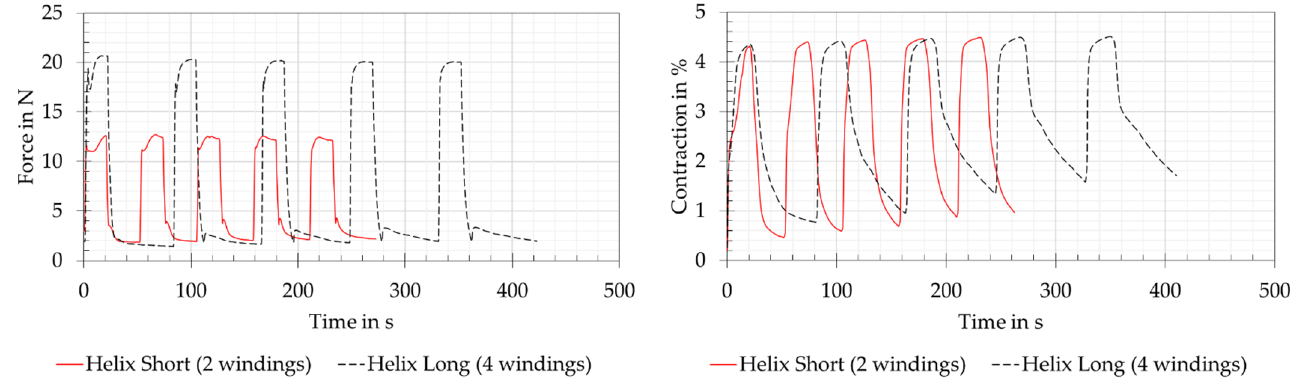
Figure 12. Helix version: force and contraction measurements for the short and long helix variants. The wire length was 450 mm for the short helix and 750 mm for the long helix. The short helix was supplied with 7 V and 0.9 A and the long helix with 14 V and 1.1 A. Both versions were preloaded with 5 N.